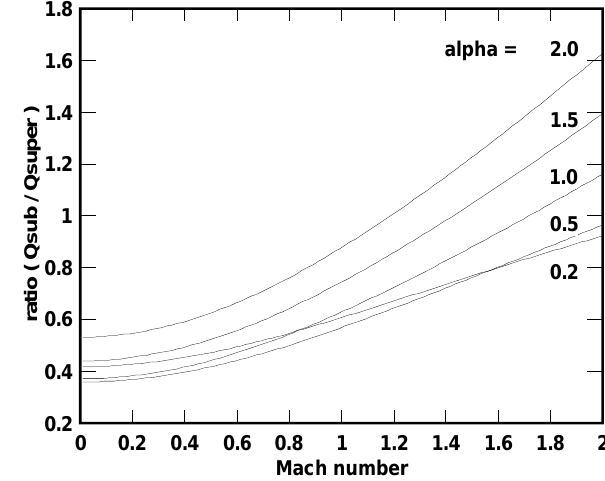
Fig. 3. Shown as a function of the H-atom flow Mach number M H is the ratio R = Q sub /Q super of the net momentum exchange rates Q super and Q sub , for various values of the temperature ratio α = T H /T p